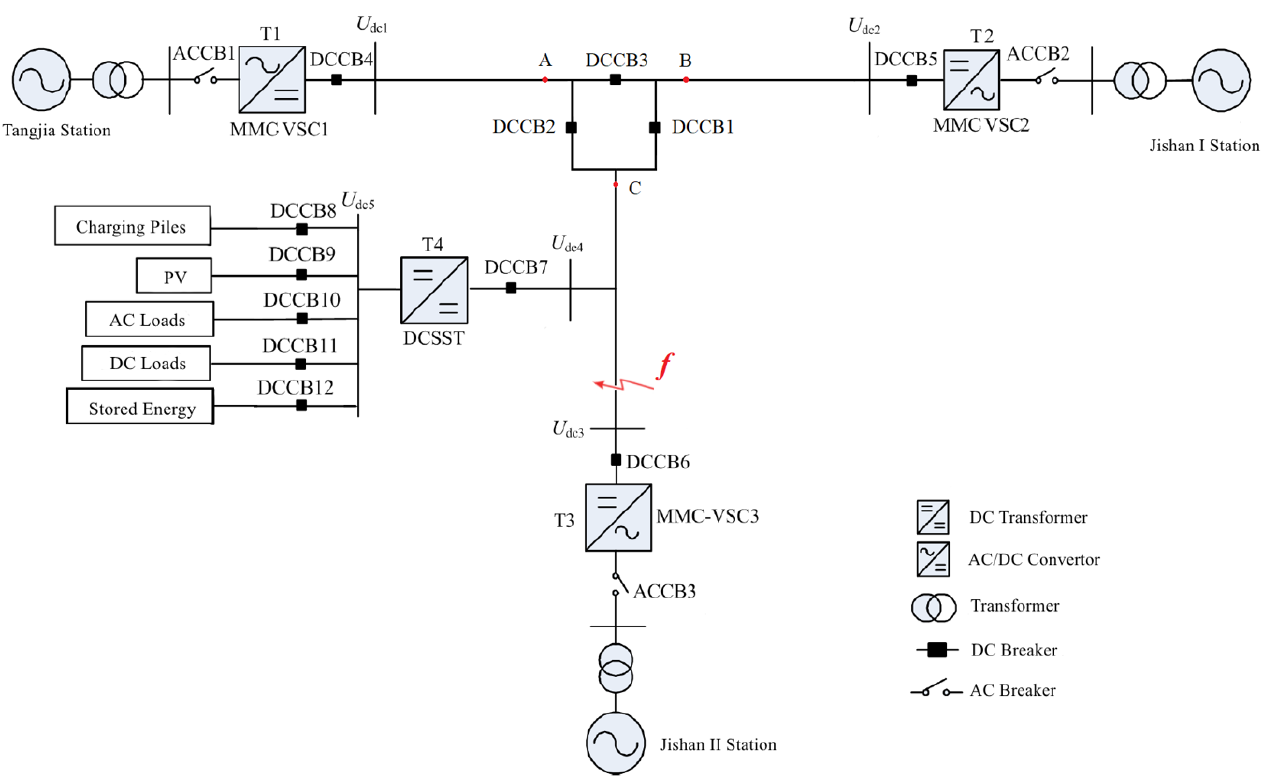
Figure 1. MTDC distribution network topology.